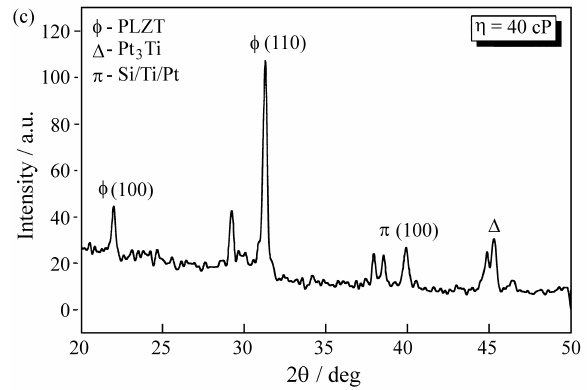
Figure 2. XRD patterns of PLZT films ( η = 40 cP) deposited on Si/Ti/Pt (100) substrate and annealed at 650 °C for 3 h in differents atmospheres: (a) air, (b) oxygen and (c)